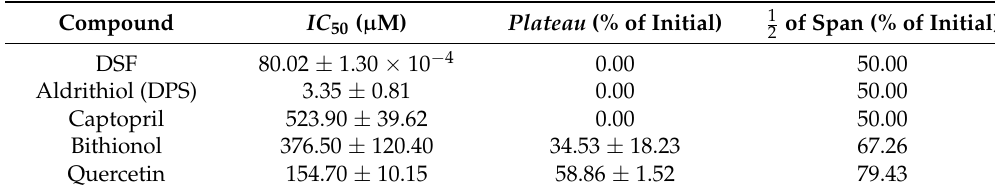
Table 1. IC 50 values of CVU inhibition by Sulphur-reactive-compounds and quercetin. Span represents the percentage of the inhibition, and 1 of the span was calculated from the difference between the 2 plateau obtained by the fitting and 100% of the initial